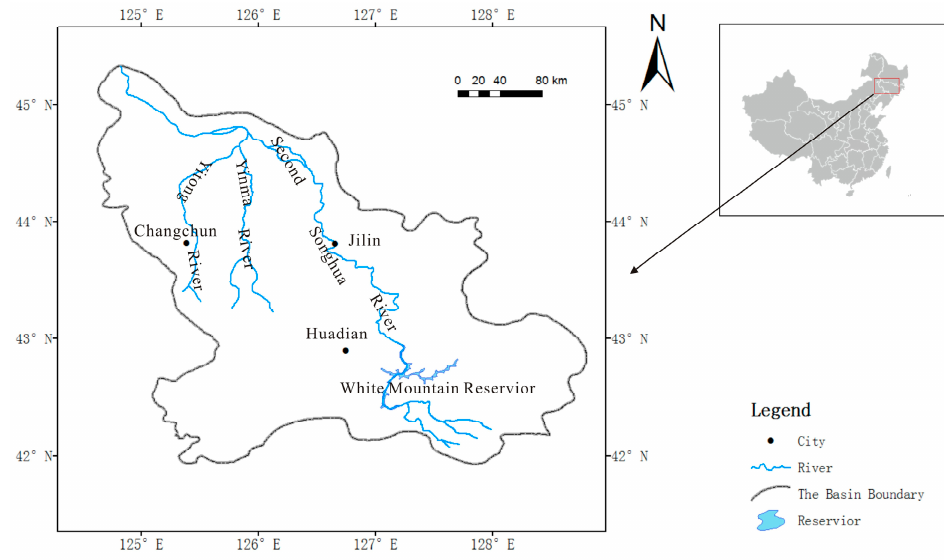
Figure 1. Main stem and tributaries of the Second Songhua River.